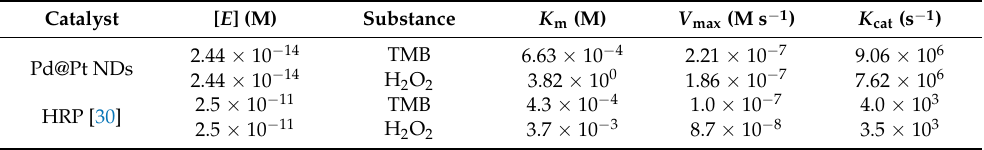
Table 1. Comparison of the kinetic parameters of Pd@Pt NDs and HRP toward the TMB + H 2 O 2 reaction a . Catalyst